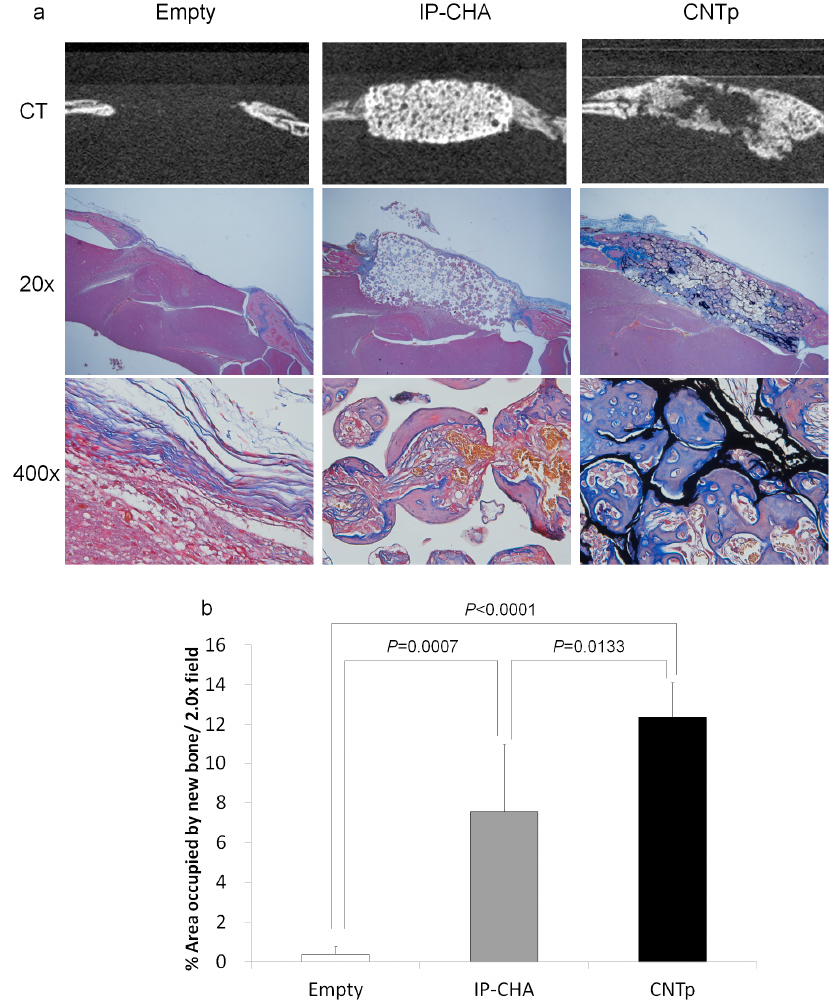
Figure 11. ( a ) Micro-CT and histological image of empty control, IP-CHA, and CNTp scaffolds combined with rhBMP-2, implanted in the calvarial defects of ddY mice for three weeks; ( b ) A bar diagram showing the newly formed bone area/20 × field in the calvarial defect of ddY mice implanted with rhBMP-2 supplemented scaffolds. Mean values were compared using one-way ANOVA, followed by Tukey’s post-hoc test ( n = 5).